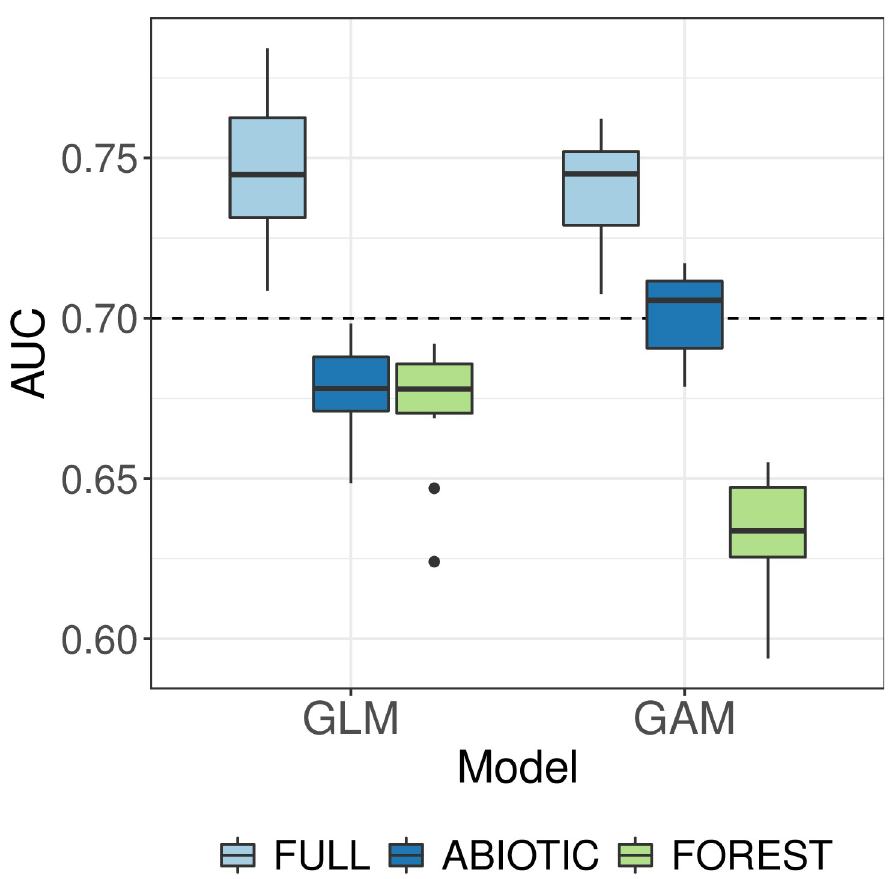
Fig 5. Cross-validation results for GLM and GAM with different predictor sets and for different time periods. Dash line shows the AUC = 0.7 threshold for acceptable level of discrimination between cases and non-cases.